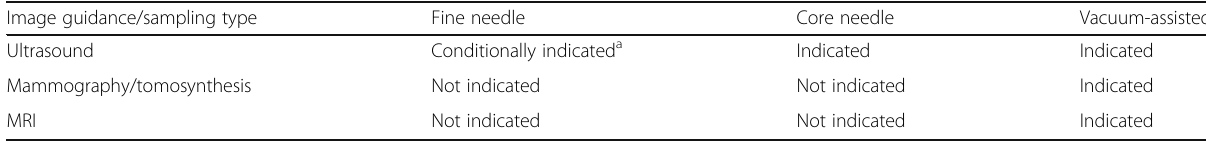
Table 1 Current options for breast tissue sampling: combinations of needle types and imaging guidance Image guidance/sampling